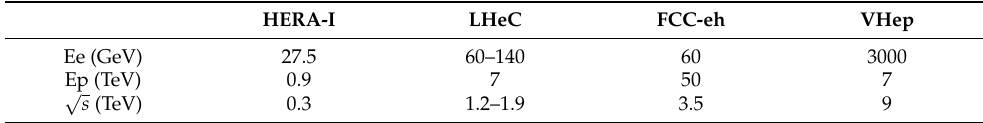
Table 7. The energies of electron (Ee) and proton (Ep) beams and the center-of-mass energy ( HERA and at the future ep